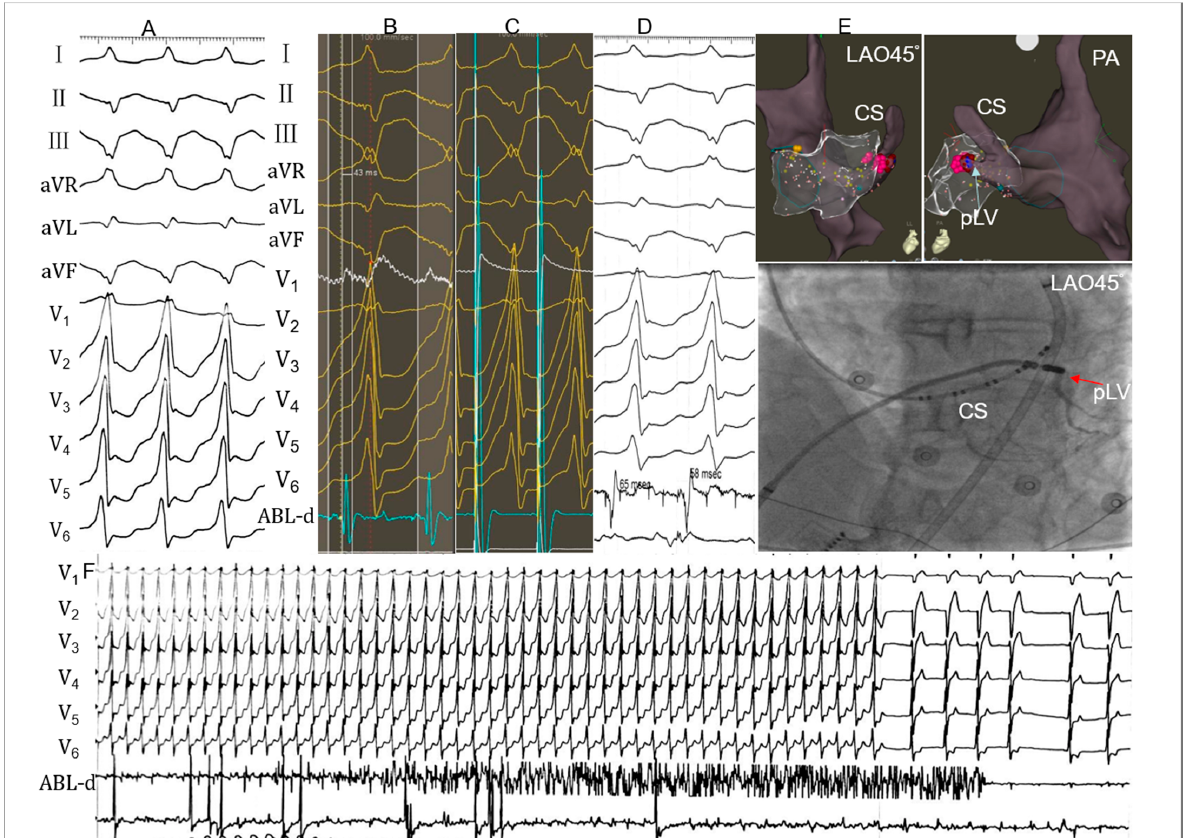
Figure 1. Example of a successful ablation of ventricular tachycardia (VT) originating from the posterior lateral vein (PLV). ( A ) Twelve-lead ECG morphology of the clinical VT. R wave in lead I, QS wave on leads II, III and aVF, r wave in lead V1, Rs wave on leads V5 and V6. ( B ) The local ventricular activation time recorded at the posterior wall of the endocardial mitral annulus (endo-MA) preceded the onset of the QRS complex by 43 ms and pacing this site led to a 95.6% concordance with the QRS complex of VT. ( C ) Cessation of the target VT is not observed within the 30 s after radiofrequency initiation (pink dots in ( E )). ( D ) Another local ventricular activation time recorded at PLV (the posterior wall of epicardium mitral annulus) preceded the onset of the QRS complex by 58 ms. ( E ) The fluoroscopic position of the successful ablation site was in the PLV. ( F ) Ablation was repeated at 43 ◦ C, 30 W with a 60 mL/min irrigation rate. Cessation of the target VT was observed 15 s after radiofrequency initiation (red dots in Figure 1E). LAO = left anterior oblique; PA: postero-anterior. ABL-d, intracardiac bipolar electrograms; PLV, posterior lateral vein; CS, coronary